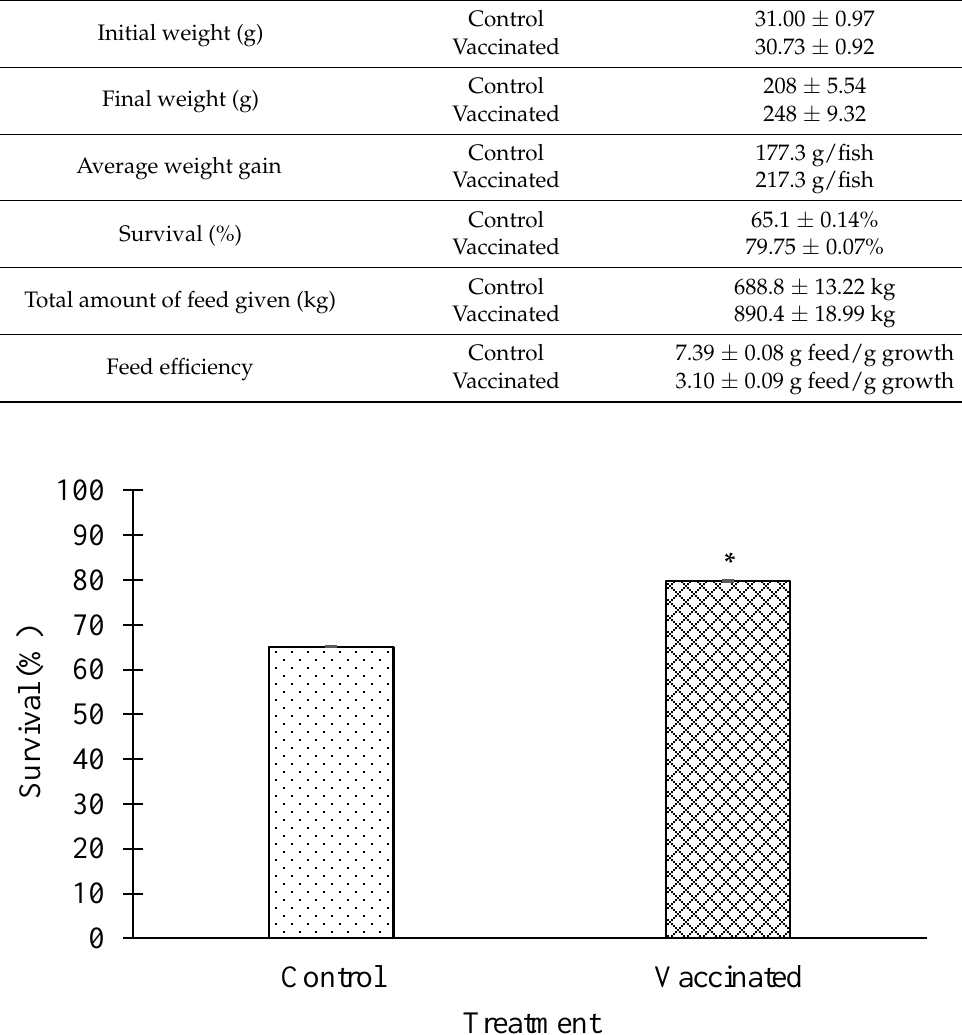
Figure 7. Percentage of survival between control and vaccinated group throughout the 112-day vaccination period. * Indicates a significant difference ( p < 0.05 ) between the vaccinated and control groups.